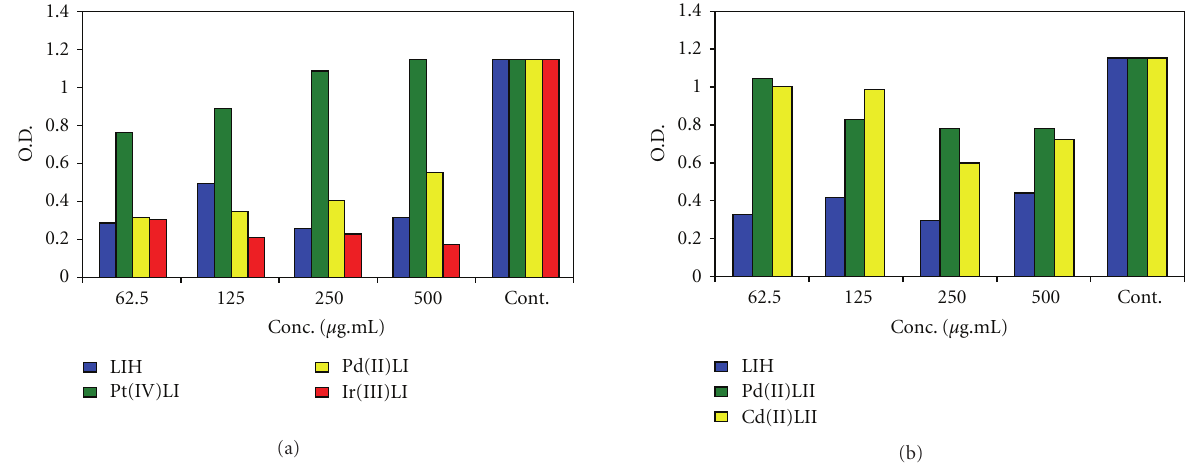
Figure 9: Cytotoxic e ff ect of L I H, L II H, and some selected metal complexes on growth of cancer cell line Hep-2 at di ff erent concentrations with exposure time 48 h.